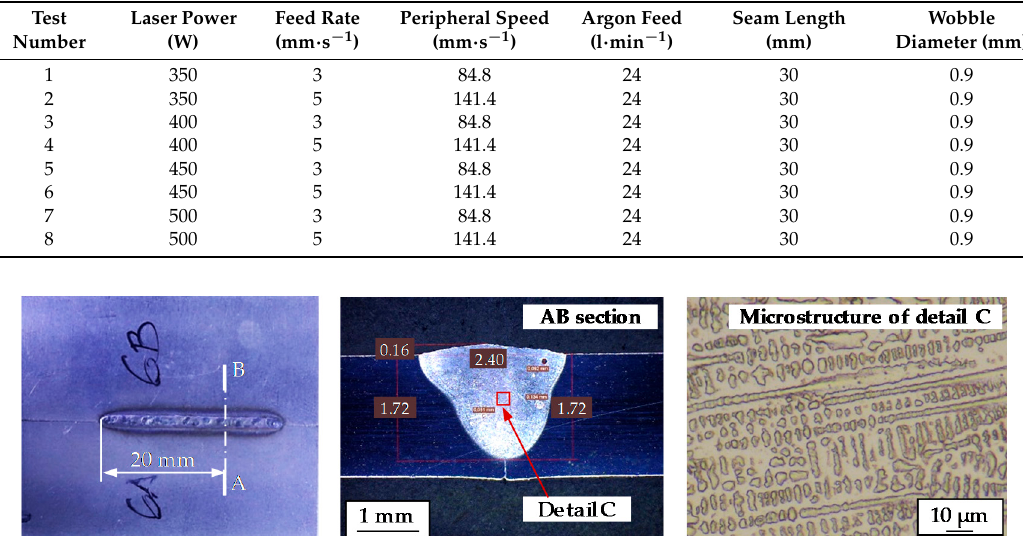
Figure 4. Wobble scanning technique employed for the welding operation. Table 3. Process parameters for the different tests.